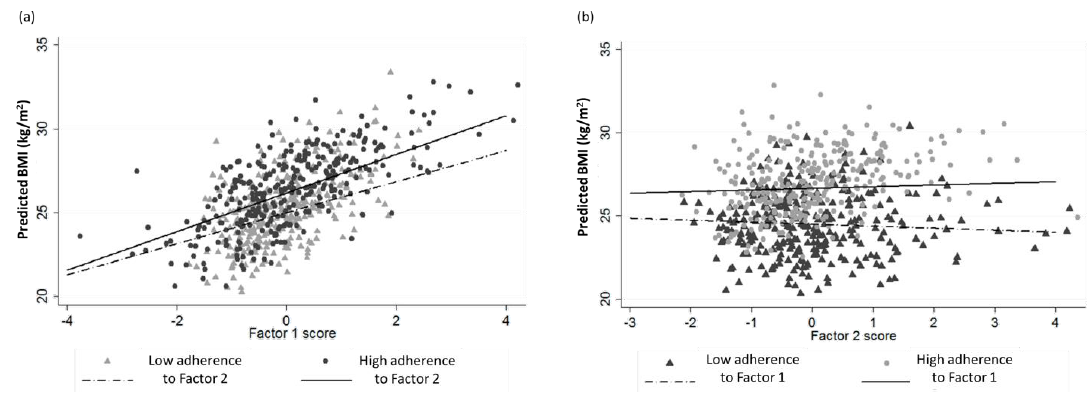
Figure 3 . ( a ) Regression plotting of predicted BMI for Factor 1 adjusted for age, gender, energy intake, physical activity, supplement user, and smoking habit categorized by adherence to Factor 2; ( b ) Regression plotting of predicted BMI for Factor 2 adjusted for age, gender, energy intake, physical activity, smoking habit, and supplement user categorized by adherence to Factor 1.